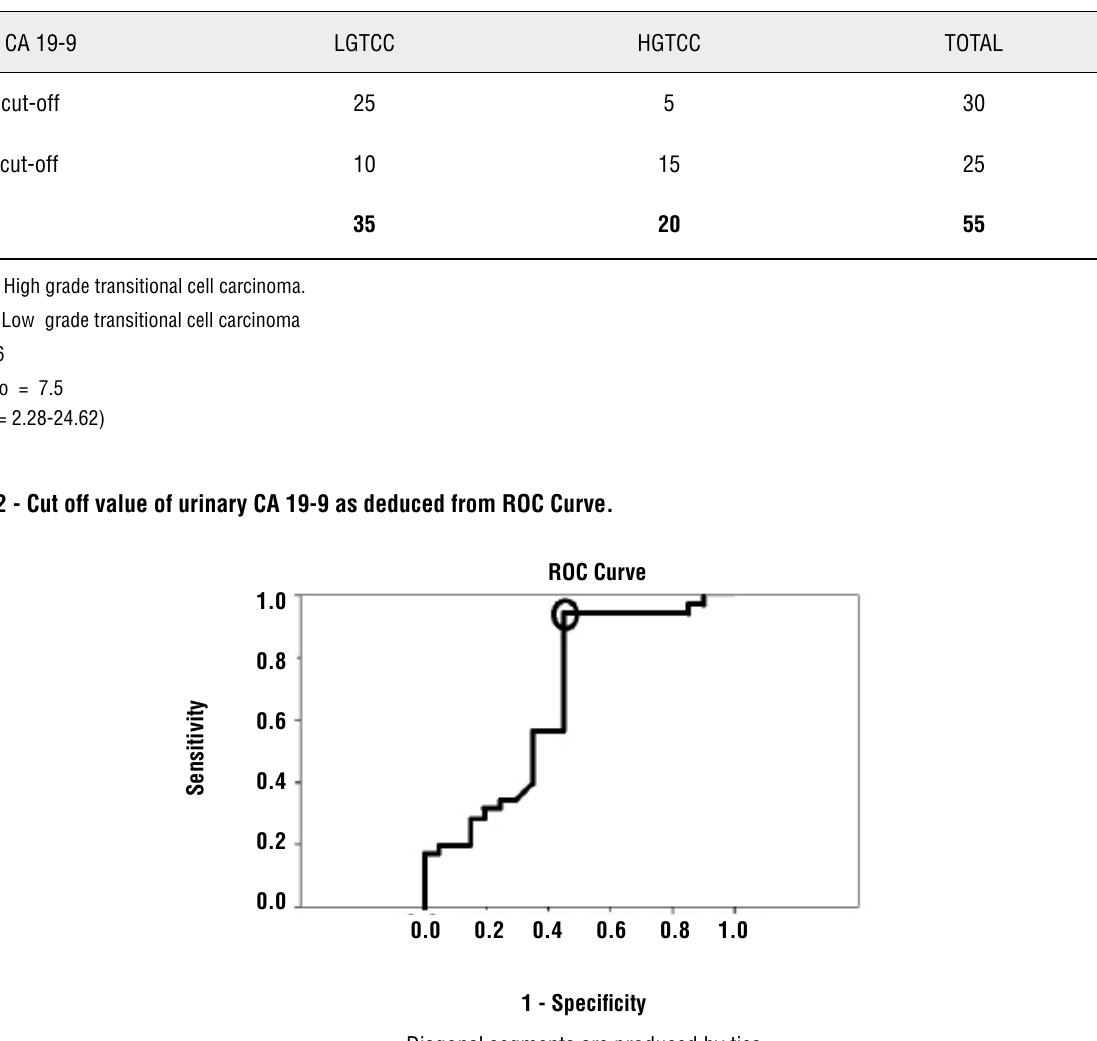
1 - Diagonal segments are produced by ties